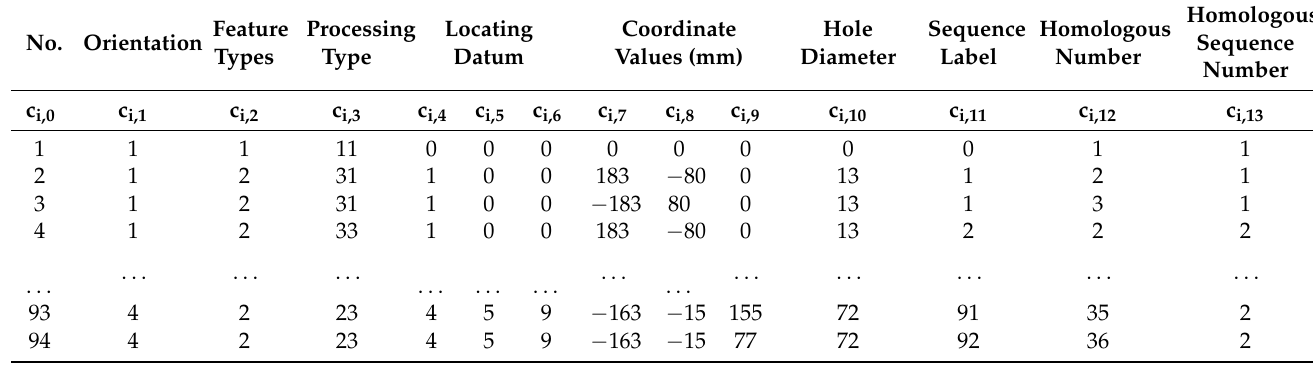
Table 2. Processing information for part